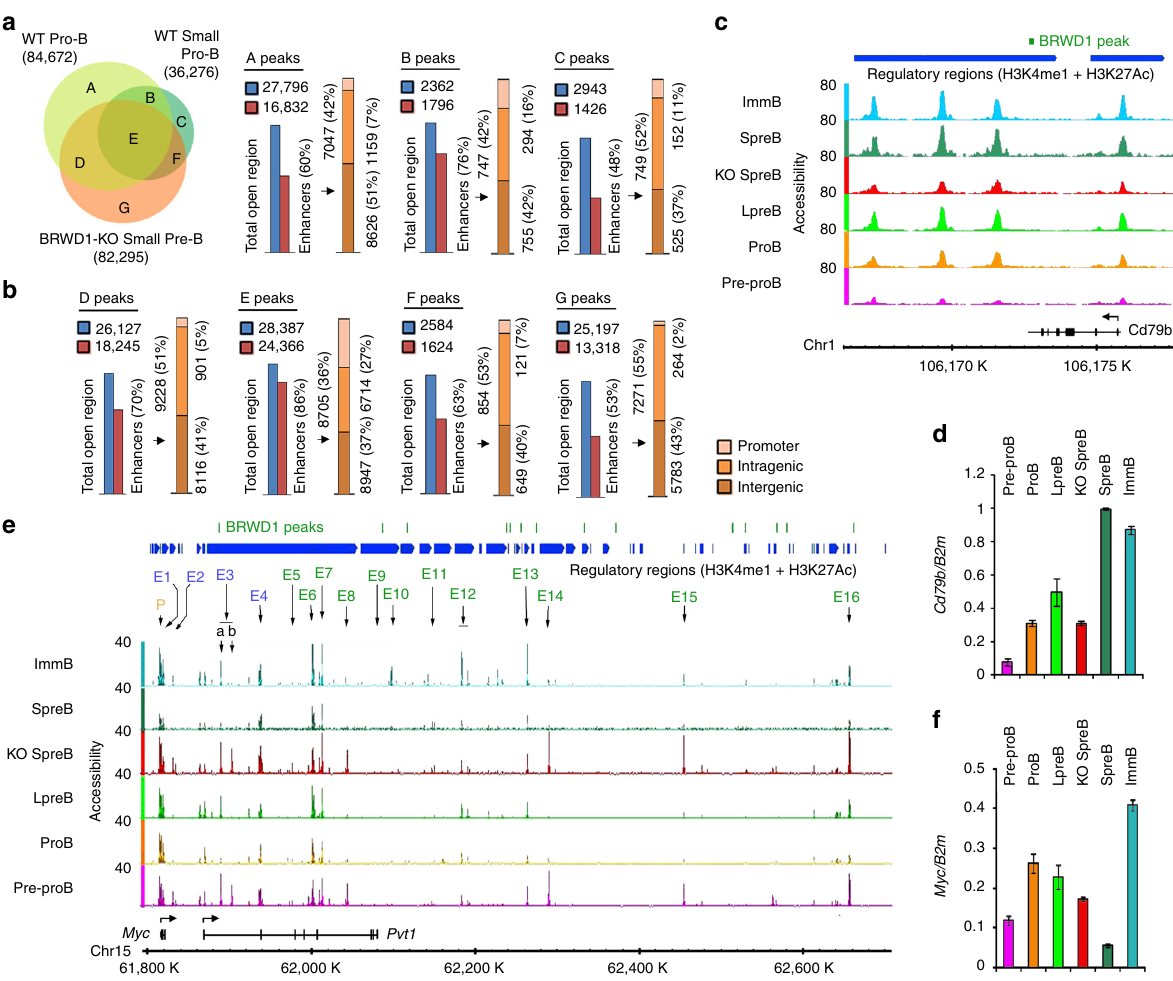
Fig. 3 BRWD1 regulates transcription by remodeling the enhancer accessibility. a Total and overlapping chromatin accessible regions in indicated B -cell progenitors with each unique area in the Venn diagram designated with a letter. b Percentage of open chromatin regions identi fi ed as enhancers (H3K4me3 + H3K27ac + ) in different chromatin regions ( a ). The number and percentage of enhancers of each open chromatin region present in different genomic regions. Promoter (-1kb to + 500 bp from TSS), Intragenic, or Intergenic. c , d Accessibility (open chromatin, ATAC-Seq) pro fi le ( c ) and corresponding quantitative mRNA expression ( d ) of Cd79b (encoding Ig β ) throughout B-cell development stages from WT pre-pro-B to immature B cells and in Brwd1 -/- small pre-B cells. BRWD1 binding sites and enhancer regions (H3K4me3 + H3K27ac + ) were shown. e Accessibility pro fi le of Myc during B lymphopoiesis and in Brwd1 -/- small pre-B cells. f Quantitative mRNA expression of Myc in indicated WT progenitors and Brwd1 -/- small pre-B cells. Data are from one experimental representative of n = 2 ( c , e ) independent experiments or are presented as average ± s.d. ( n = 3) ( d , f